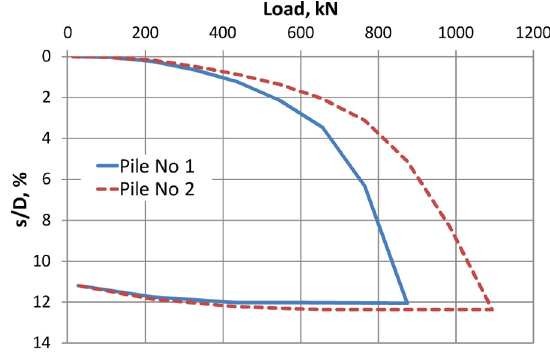
Fig. 3. Results of the pile static load test Table 1. Data on piles and static load tests Pile Diameter, No. D mm